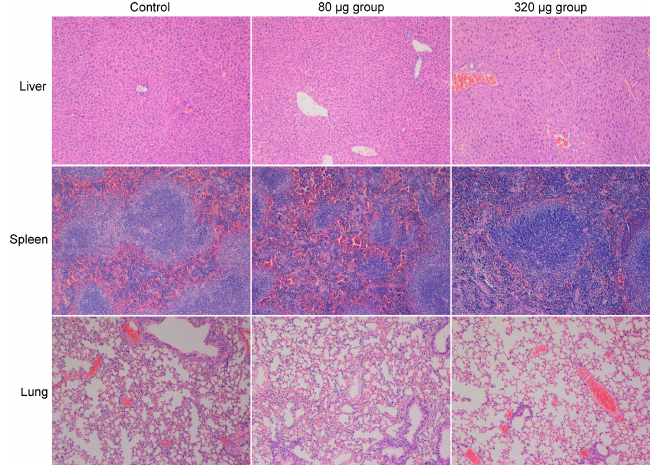
Figure 4. Histopathological observations of the mice exposed to CNSI at 28 days post intravenous exposure (100 × ).